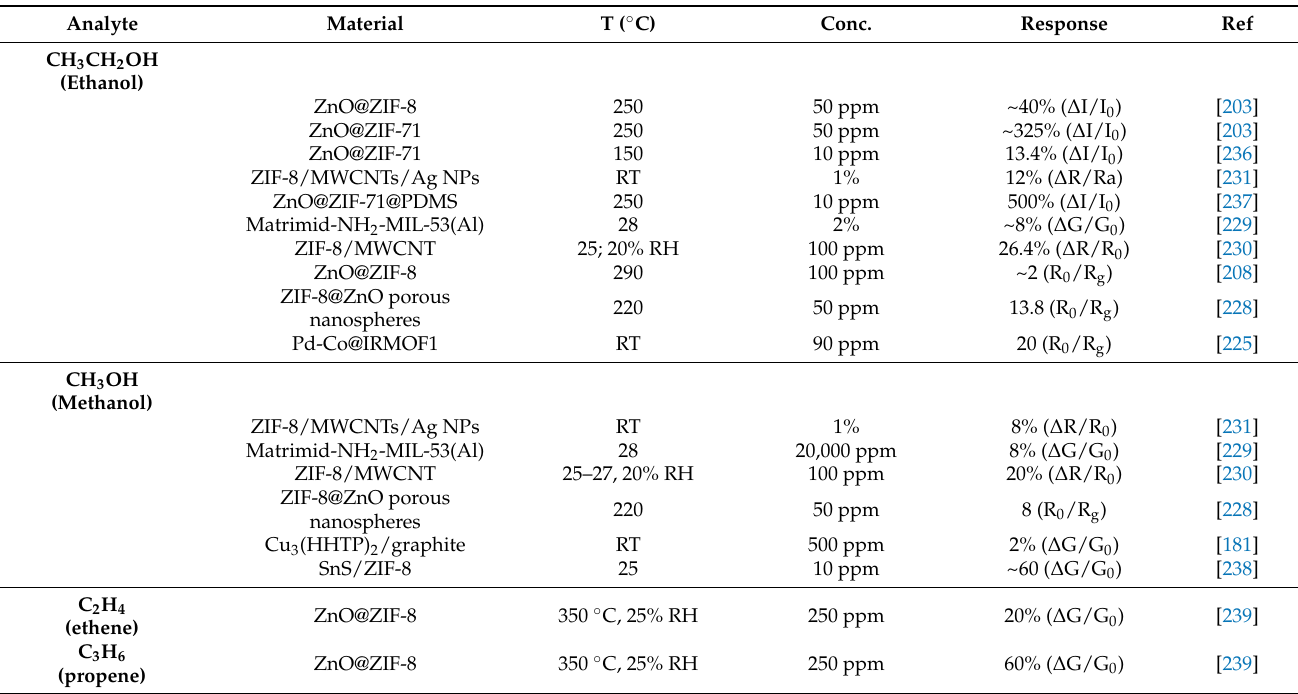
Table 4. References on the use MOF-based composites as gas sensors employing methods